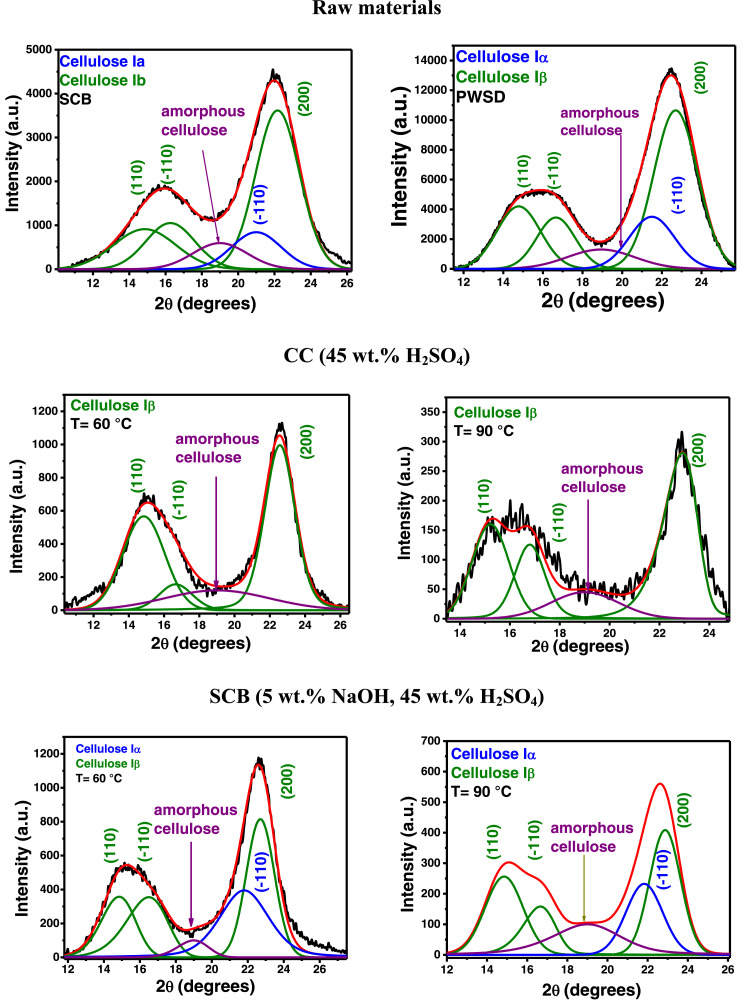
Separation of amorphous and crystalline phases in dependence of synthesis parameters, using the Shirley background subtraction with a Gaussian- Lorentzian profile, of raw materials, CC (45 wt.% H2SO4) and SCB (5 wt.% NaOH, 5 wt.% H2SO4).